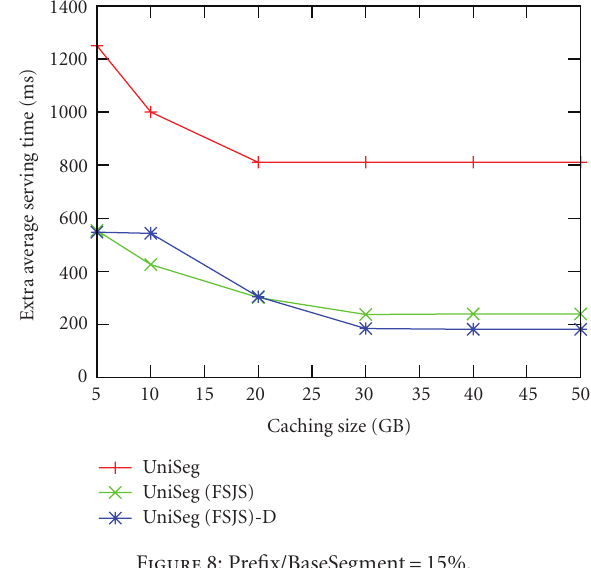
Figure 8: Prefix/BaseSegment = 15%.